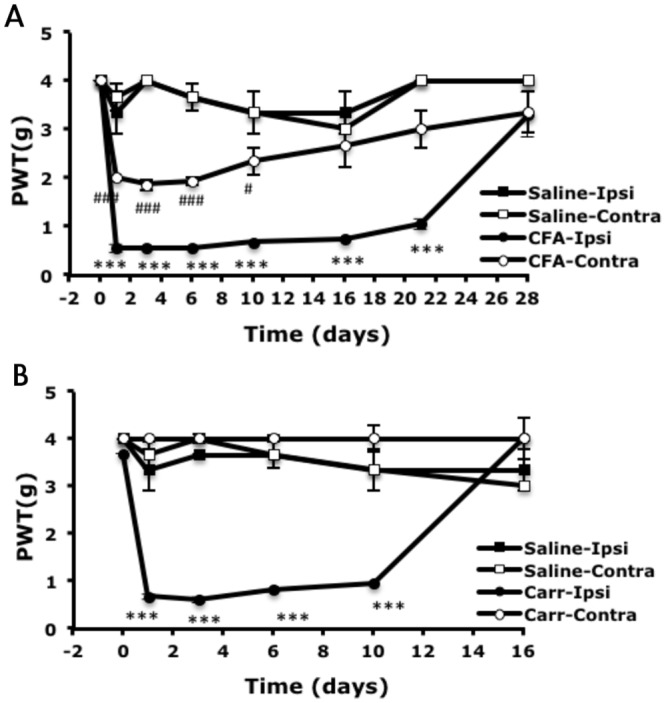
Mice show mechanical hyperalgesia with peripheral inflammation induced by complete Freund’s adjuvant (CFA) or carrageenan injection.Wild-type male CD1/ICR mice (8–12 weeks old) received intraplantar injection in the right hind paws with 25 μl CFA (50% in saline, A), carrageenan (Carr; 20 mg/ml, B), or saline (A, B). The threshold of paw withdrawal (PWT) to mechanical stimuli was measured before (t = 0) and after injection. Data are mean±SEM of total tested mice (n = 3–6 per group). ***p<0.001 compared to saline-injected ipsilateral group; ###p<0.001 compared to saline-injected contralateral group by two-way ANOVA with a post-hoc Bonferroni test.